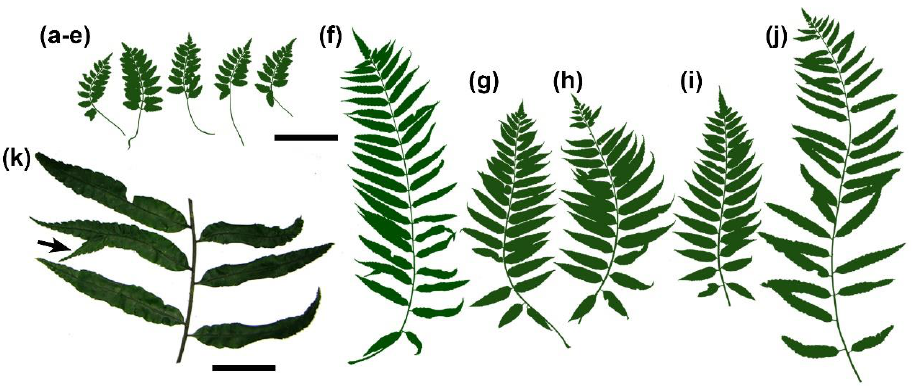
Figure 1. Leaves in Mickelia scandens . ( a – e ) Samples of the terrestrial form and ( f – j ) from the climbing form. The silhouettes are scans from actual leaves at the same scale. ( k ) Detail of the leaf of Figure 1f, with a pinna bearing a basiscopic anomalous pinnule (arrow). Bars: ( a – j ) 10 cm; ( k ) 4 cm. Int. J. Mol. Sci. 2020 , 21 , x FOR PEER REVIEW We isolated three different KNOX gene homologs from Mickelia scandens (Supplementary